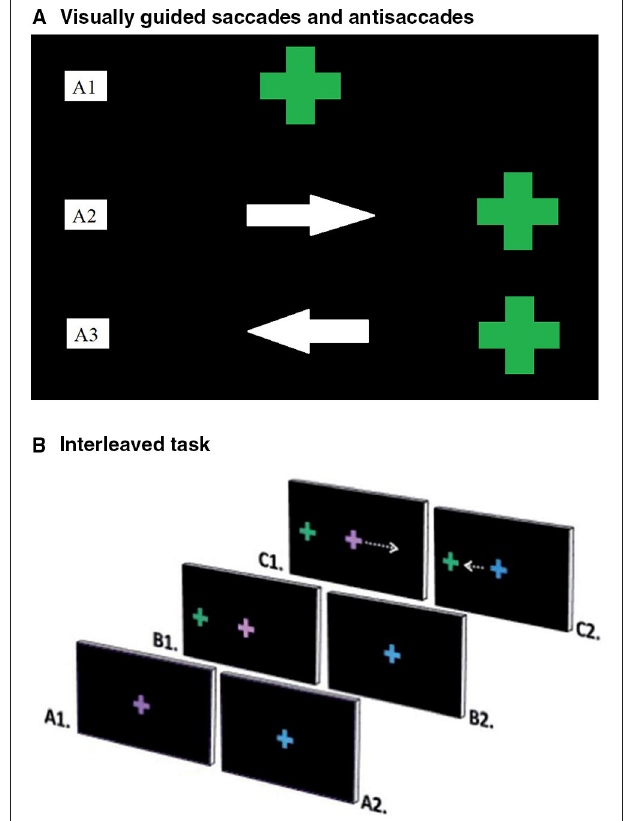
FIGURE 1 | (A) Ocular motor tasks. (A) Visually guided saccades and Antisaccades. Visually guided saccades assessed baseline visual pathway integrity ( 24). Participants fixated on a central green cross (A1) , which moved right or left and back to centre. They were instructed to follow the cross with their eyes as accurately as possible (A2) . Antisaccades assessed inhibitory control; the ability to inhibit an automatic response, in favour of performing a goal-oriented response requiring more effort ( 8). Participants fixated on a central green cross (A1) that disappeared and reappeared either to the left or right on screen. Participants were instructed not to look at the green cross and instead to look at the mirror opposite location to the green cross when it reappeared (A3) . (B) Interleaved task. The interleaved task assessed attention and working memory by presenting a stimulus, which cued participants to respond in one of two ways ( 25). Participants fixated on the centre of the screen, where either a purple (A1) or blue (A2) cross appeared. A green cross then appeared peripherally (B1) . Participants performed a prosaccade or antisaccade movement, depending on the colour of the initial cross. An antisaccade was cued by the purple cross (C1) and a prosaccade by the blue cross (C2) . Repeat consecutive trials were considered easier than switching tasks between trials.